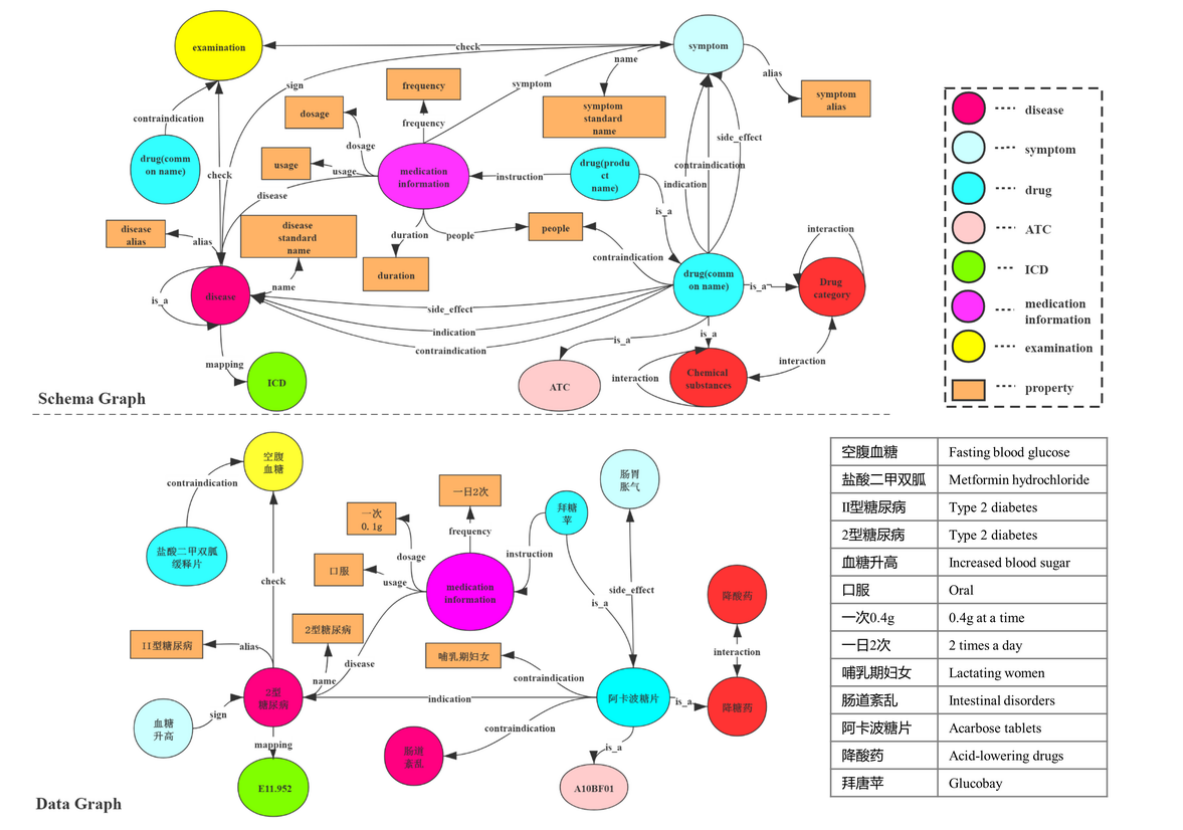
Figure 2. Medical knowledge graph schema (class) and a data graph example (instance). ATC: Anatomical Therapeutic Classification; ICD: International Classification of